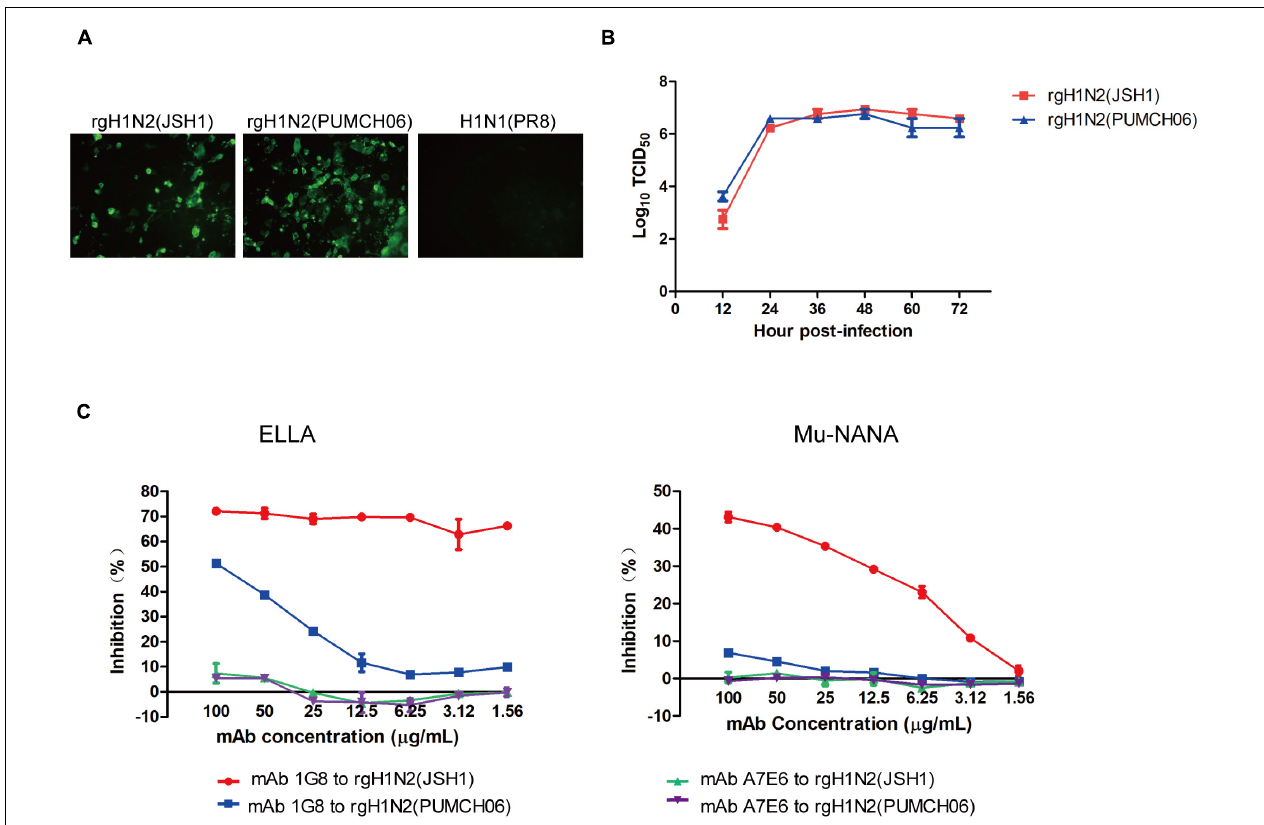
FIGURE 1 | Generation of rgH1N2 viruses and reactivity to mAb 1G8. (A) Reactivity of mAb 1G8 to rgH1N2(JSH1), rgH1N2(PUMCH06), and H1N1(PR8) viruses in IFA. (B) Viral growth kinetics of rgH1N2 viruses in A549 cells. (C) NI activity of mAb 1G8 to rgH1N2 viruses measured by ELLA and Mu-NANA assay. The mAb A7E6 was used as negative control. All data of viral growth kinetics and NI assay were performed with Graphpad Prism v.5 and represented as mean ± SEM.